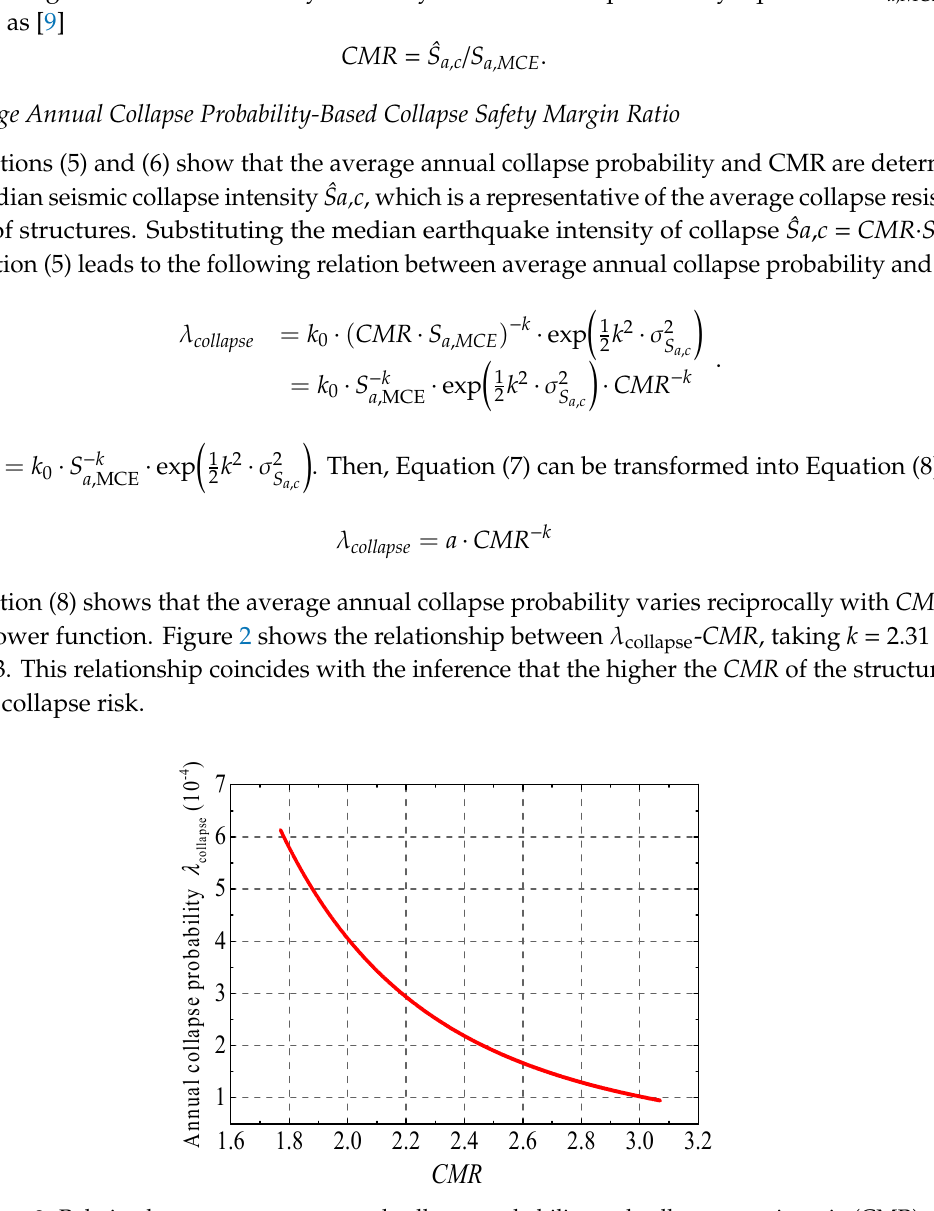
Figure 1. Seismic hazard curves: ( a ) Seismic hazard curve in the linear coordinate; ( b ) Seismic hazard curve in the log–log coordinate.